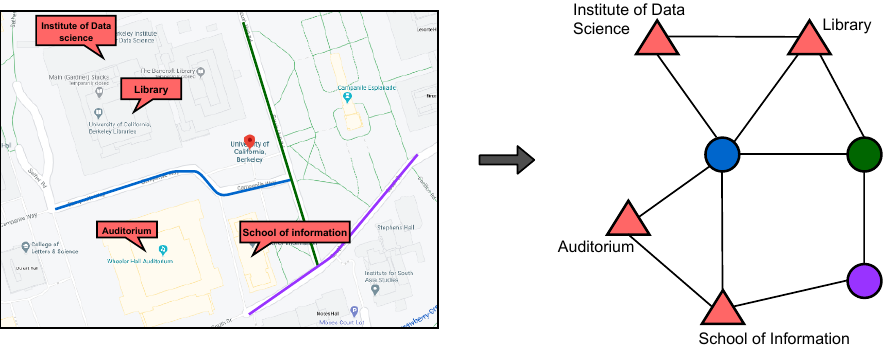
Figure 1. Figure showing a heterogeneous graph representation of spatial entities from a map. To the left is a map snippet with streets and buildings highlighted. To the right is the graph representation with the triangles representing buildings on the maps, circles representing the streets. The edges between the shapes denote some defined relation such as distance or spatial intersection. An abstract depiction of heterogeneous graph representations is shown in Figure